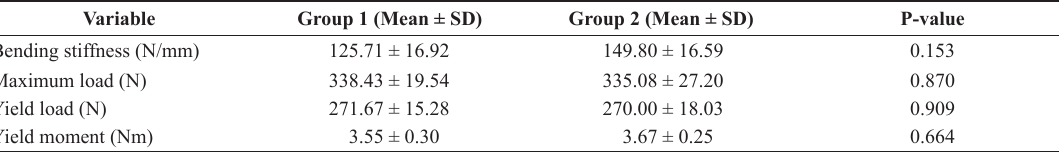
Table 1. Mean values and standard deviation (SD) for each variable evaluated in Groups 1 and 2 under static axial compression tests. Variable